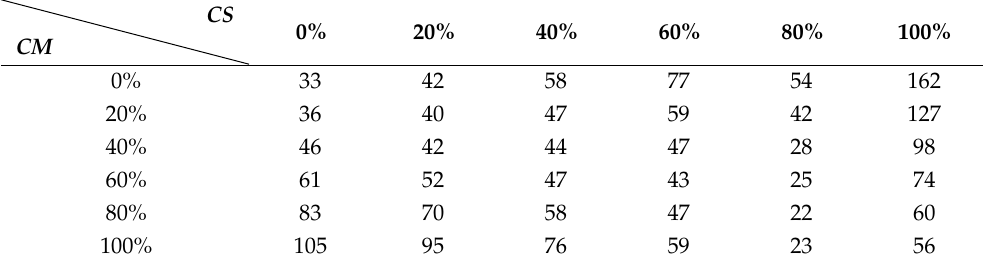
Table 8. Settling time for combinations of CM and CS ,